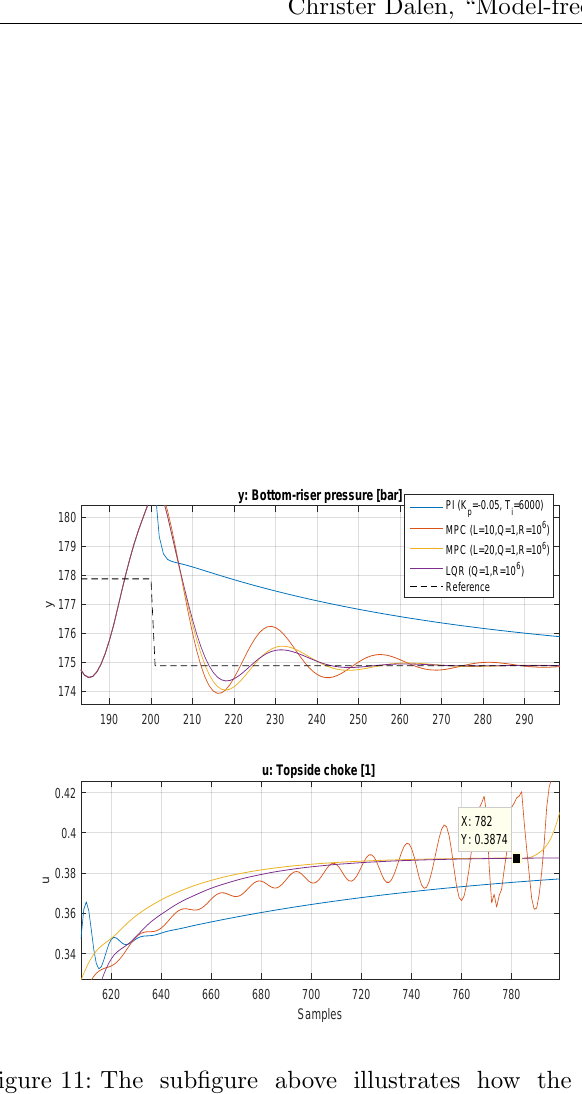
Figure 11: The subfigure above illustrates how the MPC converges to the LQR when the pre- diction horizon, L increases. figure below illustrates the controller per- The MPC (L=20) and the LQR, based @0.20, are able to stabilize the slugging regime up to choke opening 0.39. (zoomed in on the first and last part of Fig. 10.